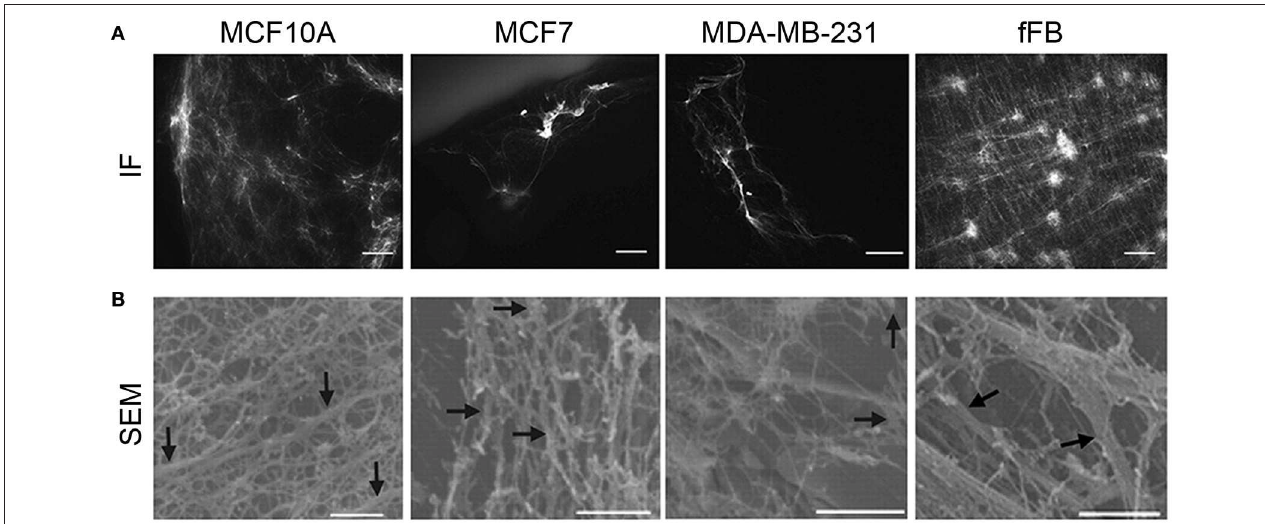
FIGURE 4 | Correlating cell type and ECM architecture after decellularization. (A) Immunofluorescence (IF, scale bars, 50 µ m) staining showed sparse distribution of ECM from multiple breast cancer cell lines, while abundant ECM deposition by human neonatal foreskin fibroblast (fFB). (B) To further visualize the deposition of ECM from the breast cancer cell lines, scanning electron microscopy (SEM, bottom row, scale bars 1 µ m) was utilized. MCF10A shows organized, interconnected fiber morphology of ECM; MCF7 has a less organized arrangement of ECM fibers; MDA-MB-231 has a thin, sparse fiber morphology; fFB has a copious monolayer of ECM containing both large and thin-diameter fibers. ECM fibers (0.1- to 0.5 µ m diameter) indicated by arrows. ( A,B reproduced with permission from Hielscher et al., 2012).